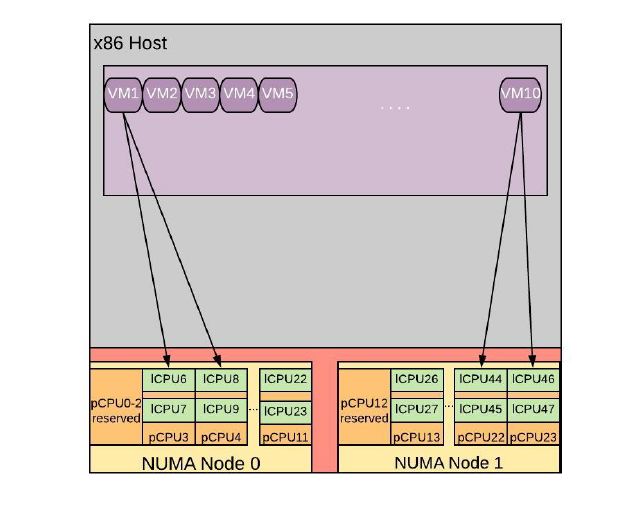
Figure 7. CPU allocation in an undersubscribed